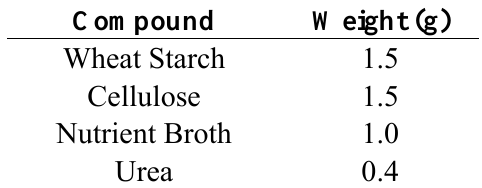
Table 3. Composition of the activation dose added to the vermiculite